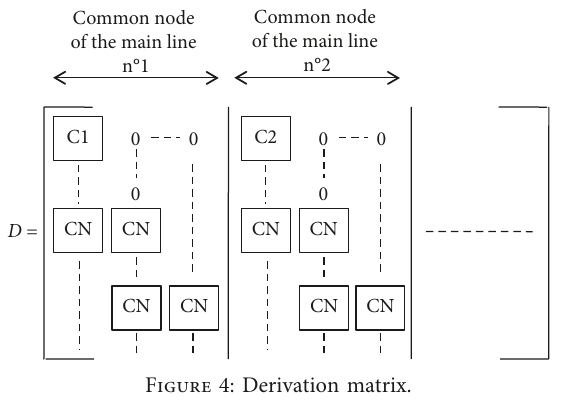
Figure 4: Derivation